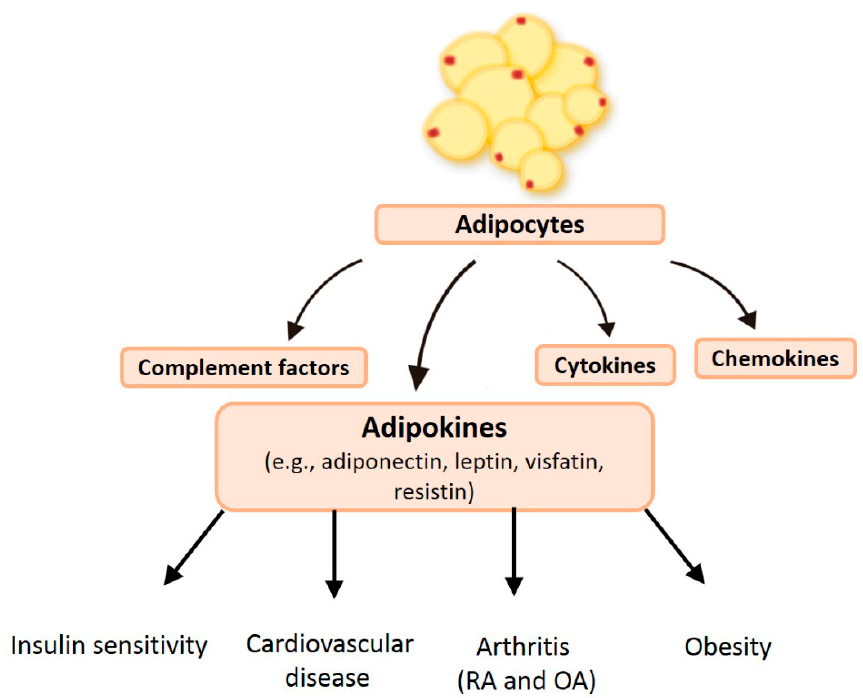
Figure 1. The important role of adipokines. Adipokines are produced mainly by adipocytes and play critical roles in several major disorders including insulin sensitivity, cardiovascular disease, arthritic conditions (i.e., RA and OA), and obesity.